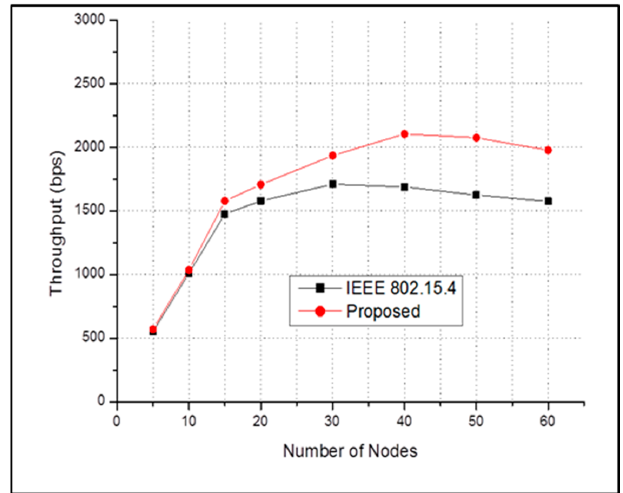
Figure 10. End-to-end average throughput in case of NO emergency event.